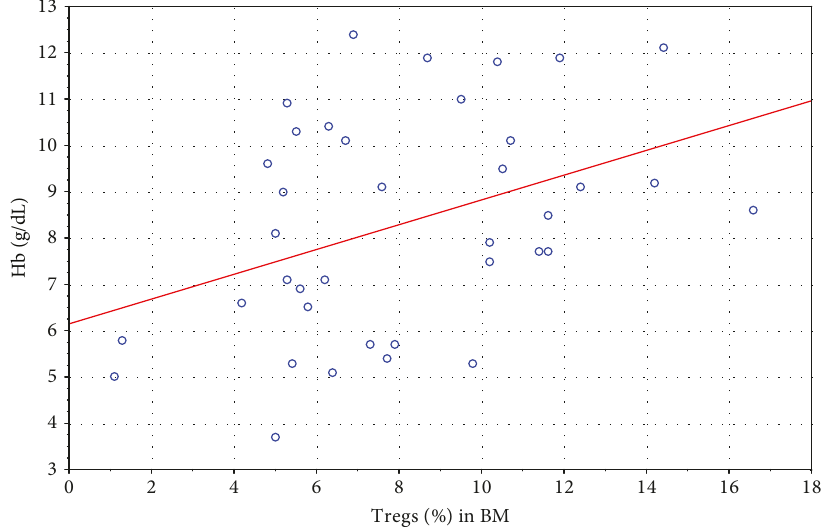
Figure 6: Correlation between the percentage of Tregs in BM at the time of diagnosis with the hemoglobin level ( R = +0 41